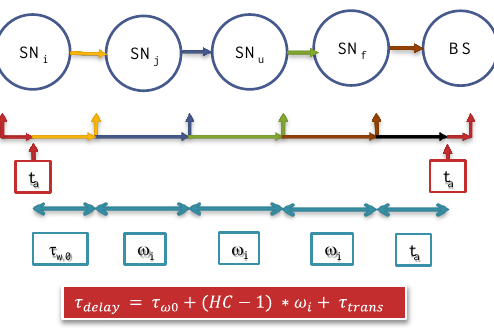
Figure 11. Total delay required to send a message from source to the BS through ( U ) hopes